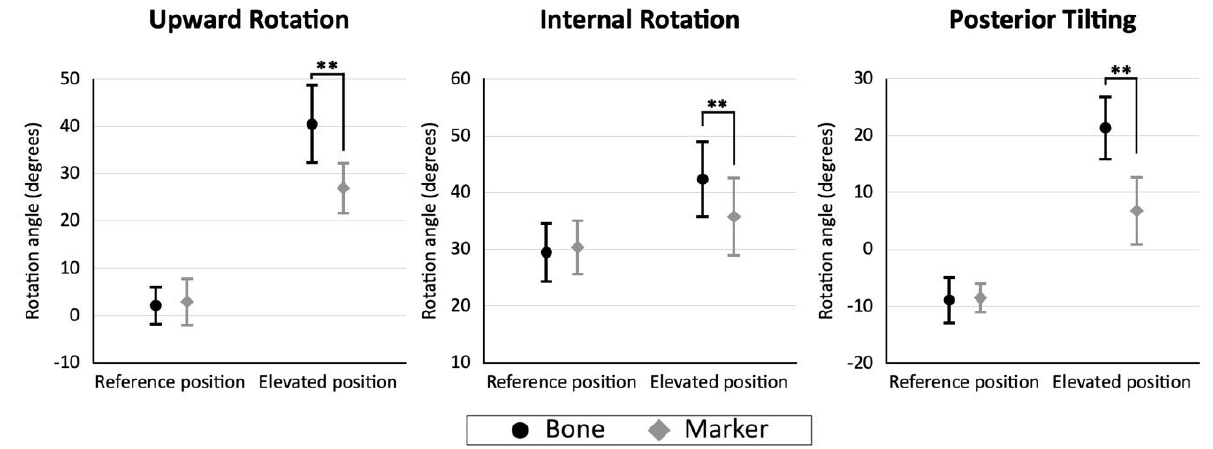
Figure 9. Bone-based (black circles) and marker-based (gray rhombus) scapulothoracic rotation angles in the reference and the elevated positions. The error bars indicate the standard deviation. ** p < 0.01.